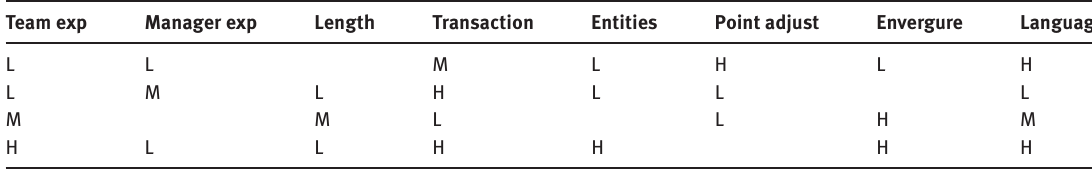
Table 1: Rules Generated from the Input